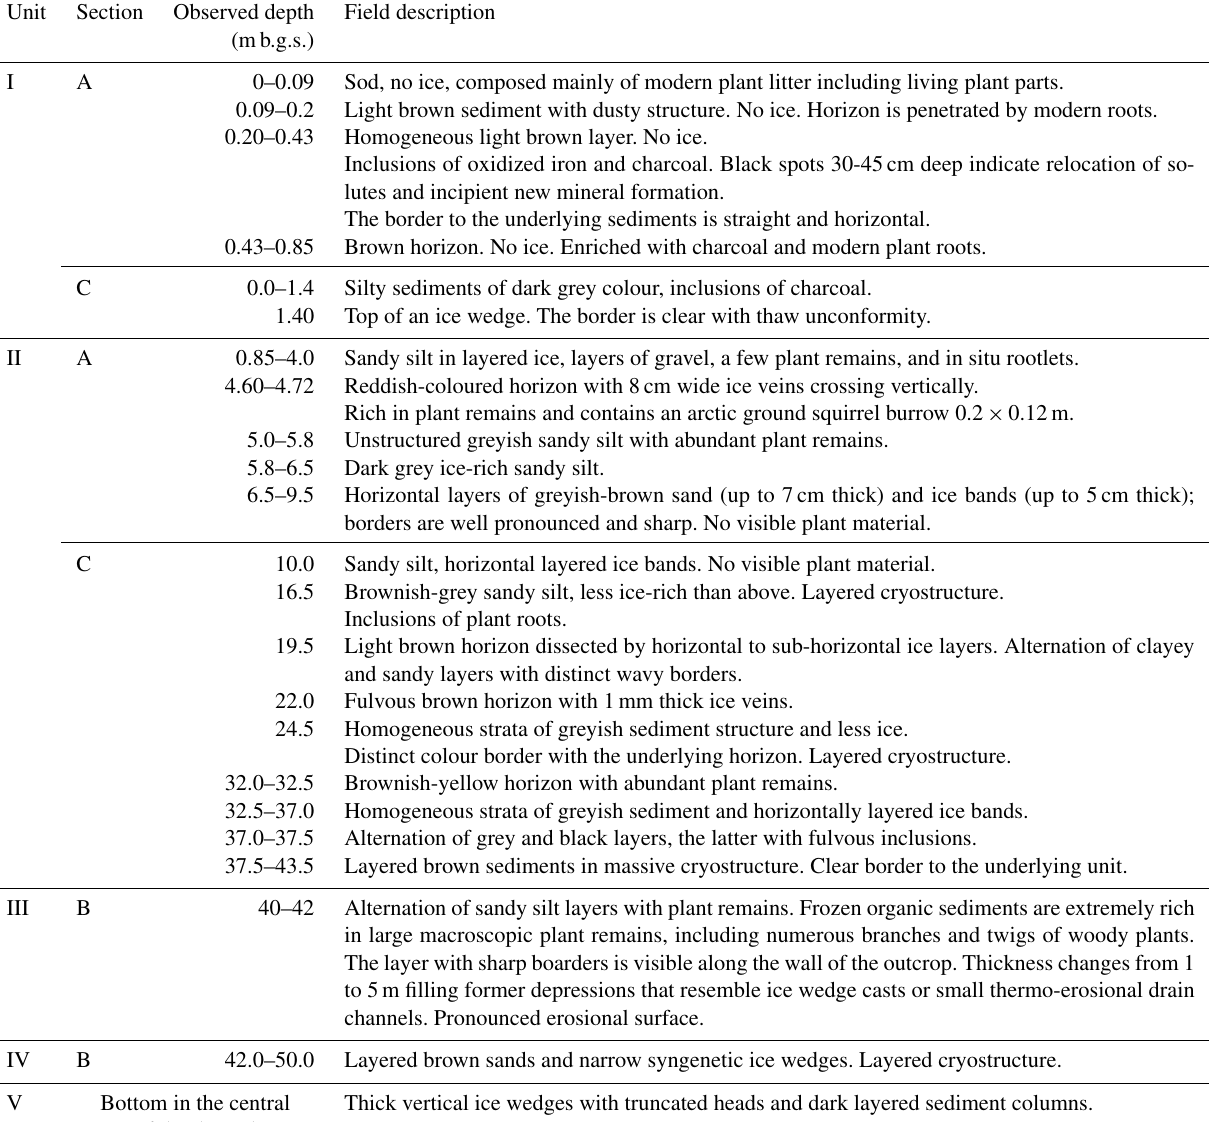
Table 1. Cryolithological description of the Batagay permafrost sequence. Unit Section Observed depth Field